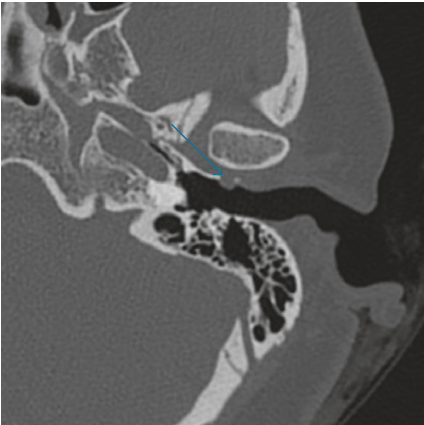
Figure 2: Axial noncontrast computed tomography of the tem- poral bone. A TMJ ganglion cyst is